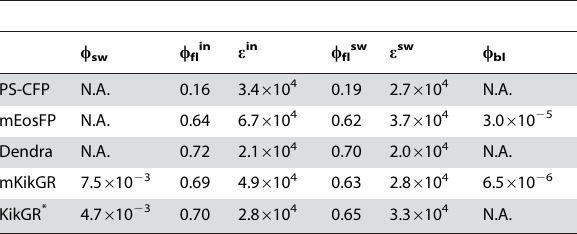
Table 1. Spectroscopic properties of monomeric photoswitchable proteins which change color on